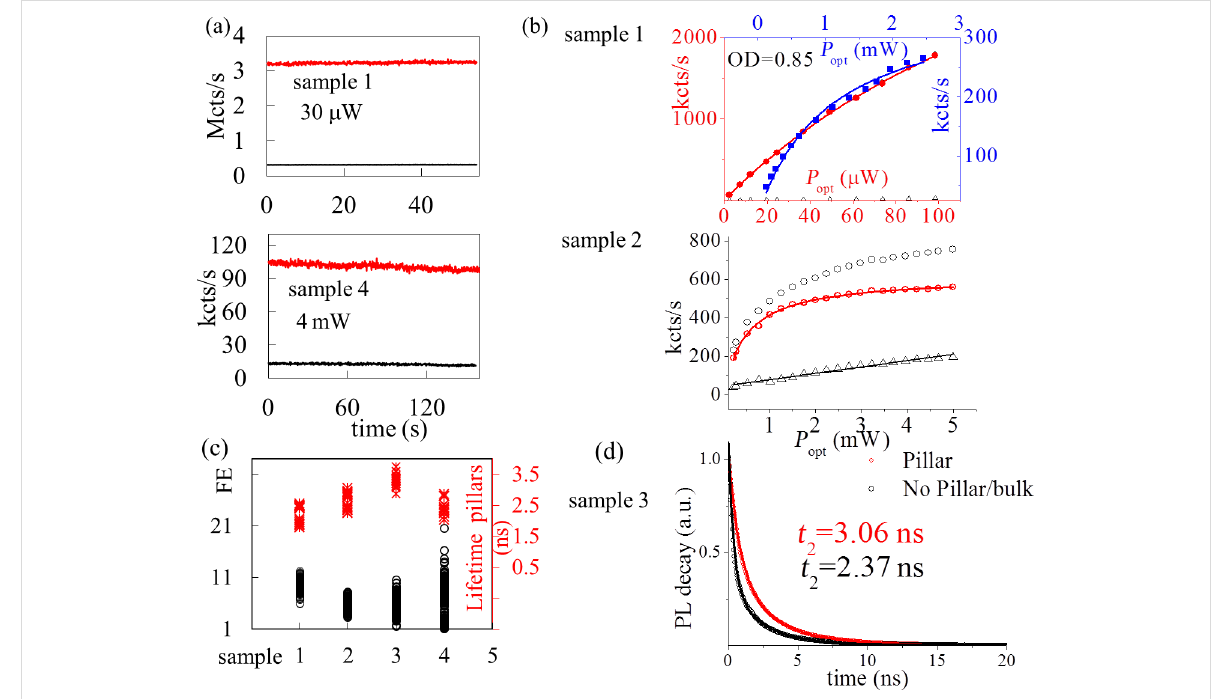
Figure 7: (a) Photostability of one micropillar and the gap region for samples 1 (top) and 4 (bottom) at excitation powers of 30 μ W and 4 mW, respec- tively. Both samples provide a fluorescence enhancement by a factor of about ten. Counts rate are measured every 167 ms. (b) Top: Power satura- tion curve for one pillar in sample 1 (red) compared with the saturation count rate of the emission in the bulk (blue). The saturation curves show the enhanced emission in the pillar by a factor of 14 and a reduction of the saturation optical power by a factor of 5.6. A neutral density filter with OD = 0.85 was used to perform the measurement. Bottom: Saturation curves for one pillar in sample 2, showing the total count rate, the background, and the signal. (c) Fluorescence enhancement (FE) of more than 100 pillars in different samples (circles) and related lifetime of the emitters in differ- ent nanopillars of the four samples. (d) Example of lifetime measurements for V Si in the pillar and in the gap for sample 3, two exponentials decays were observed, the long component of the lifetime is shown. The ratio of the lifetime between the emitters in the bulk and in the pillar (for the longest pillar lifetime measured), τ bulk / τ pillar , is